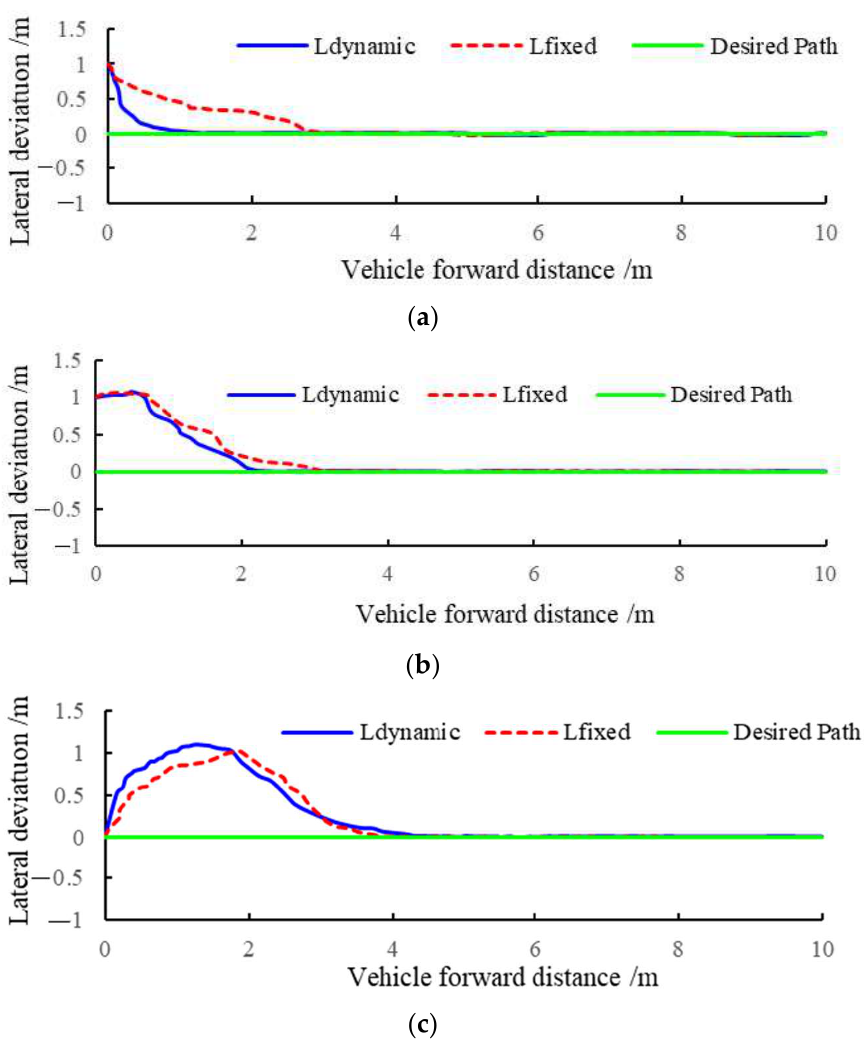
Figure 8. Linear tracking track in different initial states. ( a ) Initial state (1 m, −90°) tracking track; ( b ) initial state (1 m, 0°) tracking track; ( c ) initial state (0 m, 90°) tracking track.